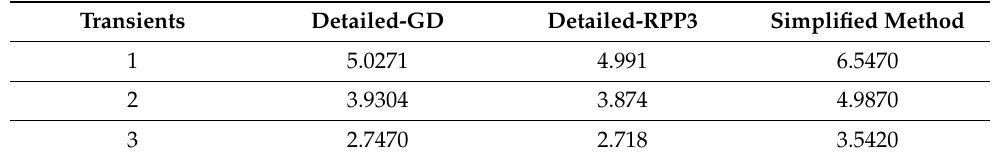
Table 5. Results of F en under different strain rate approaches.